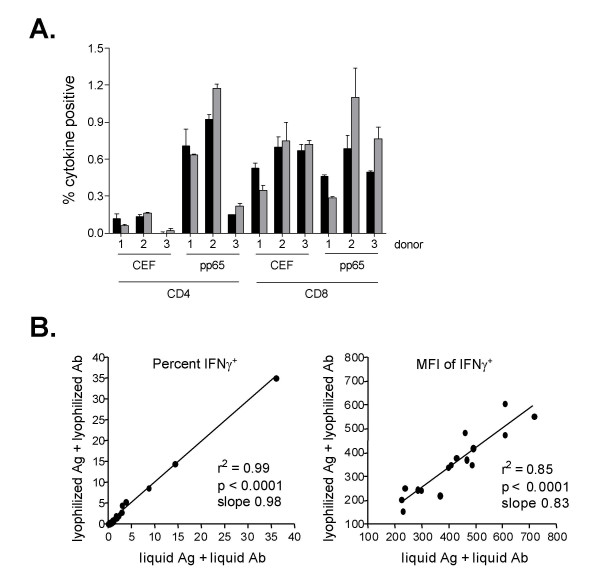
Comparison of liquid and lyophilised reagents. Comparative results are shown with backgrounds subtracted; no significant differences in backgrounds were seen with liquid versus lyophilised reagents (data not shown). (A) Data from one site that compared cocktail 1 (CD4 FITC/IFNγ +IL-2 PE/CD8 PerCP-Cy5.5/CD3 APC) in liquid and lyophilised form in Experiment 4. Black bars indicate liquid antibodies, grey bars indicate lyophilised antibodies. Error bars indicate SEM of duplicate wells. (B) Combined comparison of liquid antigen + liquid antibodies versus lyophilised antigen + lyophilised antibodies. Whole blood was activated with either SEB or pp65 peptide mix, and the percentage of IFNγ+ cells (CD4+ or CD8+) were compared with liquid versus lyophilised reagents (left panel). A similar comparison was made for the mean fluorescence intensity (MFI) of IFNγ+ cells (CD4+ or CD8+) (right panel). Similar results were obtained using PBMC (not shown).